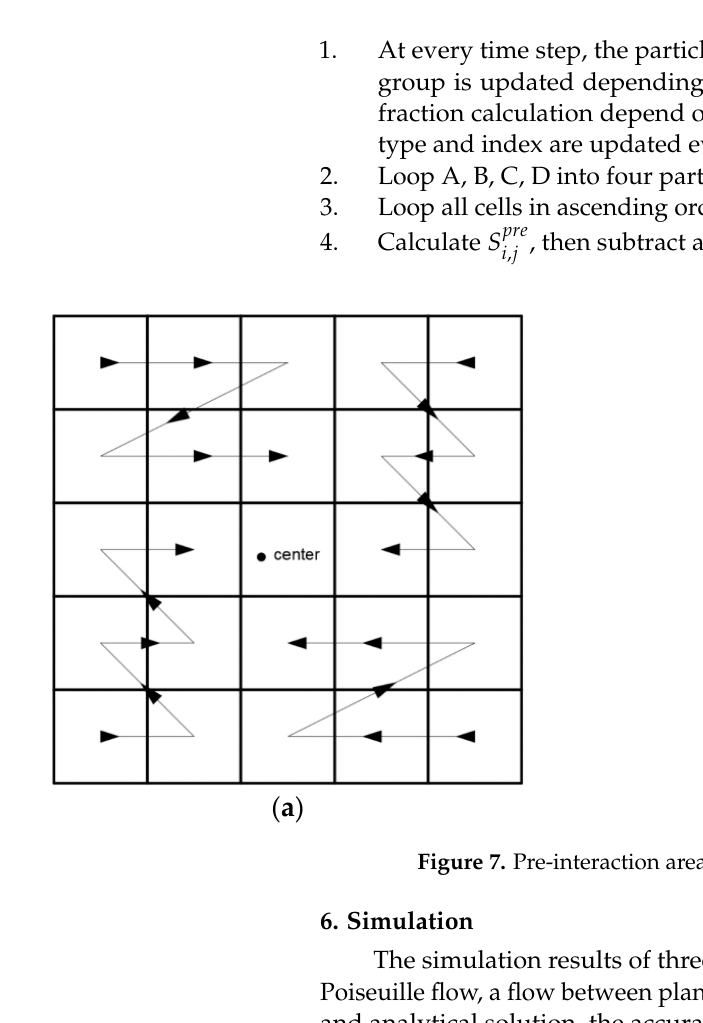
Figure 8. Poiseuille flow. The distance between two plates is H, and fluid viscosity is 𝜐 . Pressure drop is re- placed with body force F 𝑏 in Equation (26).